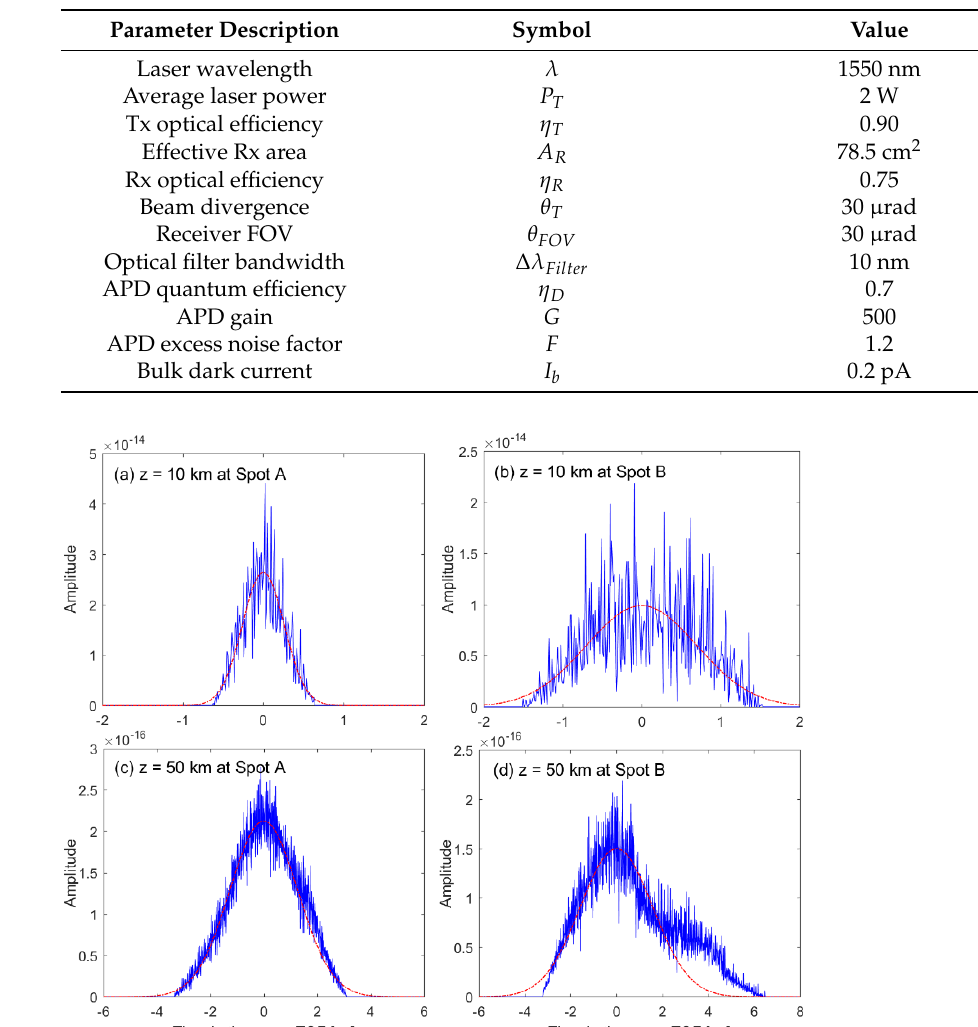
Table 1. Transmitter and receiver parameters used in the numerical simulation.